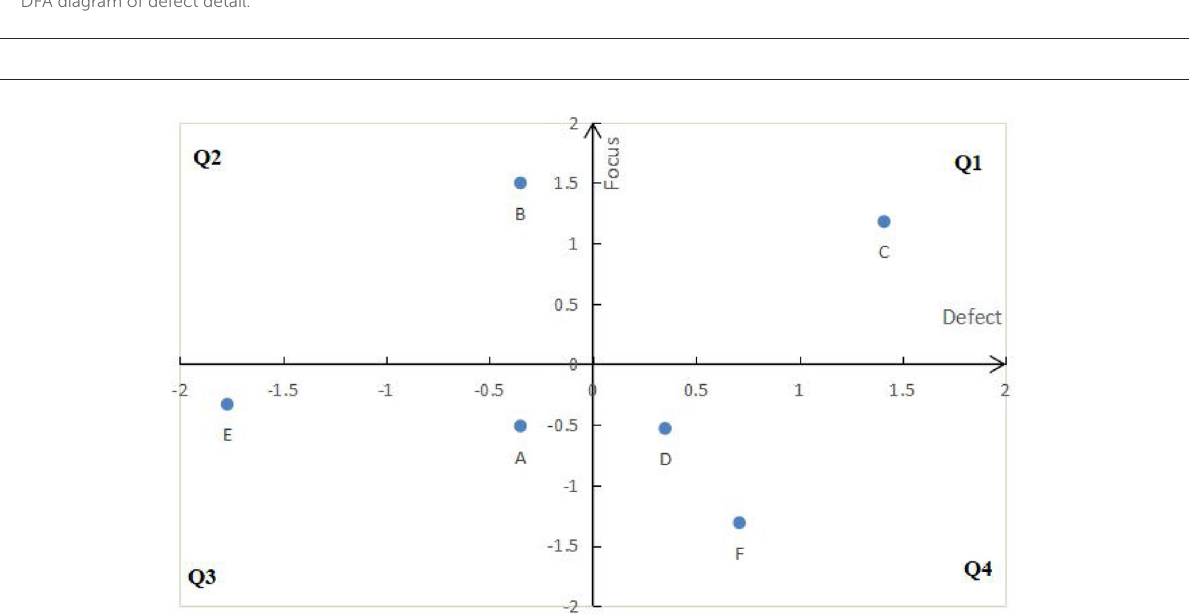
FIGURE7 DFA diagram of defect